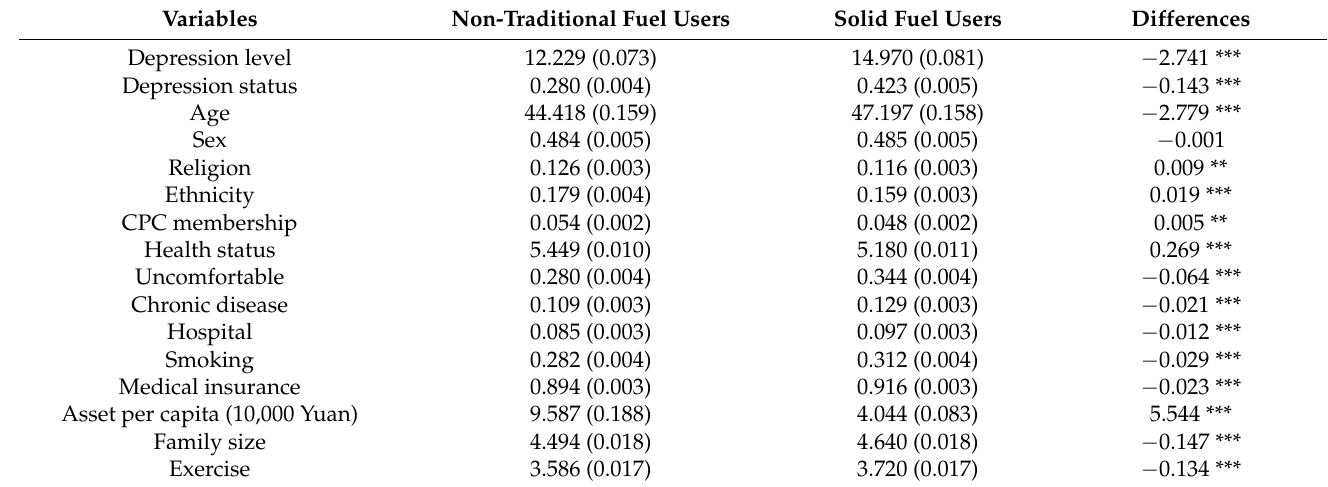
Table 2. Mean differences in characteristics between solid fuel users and non-traditional fuel